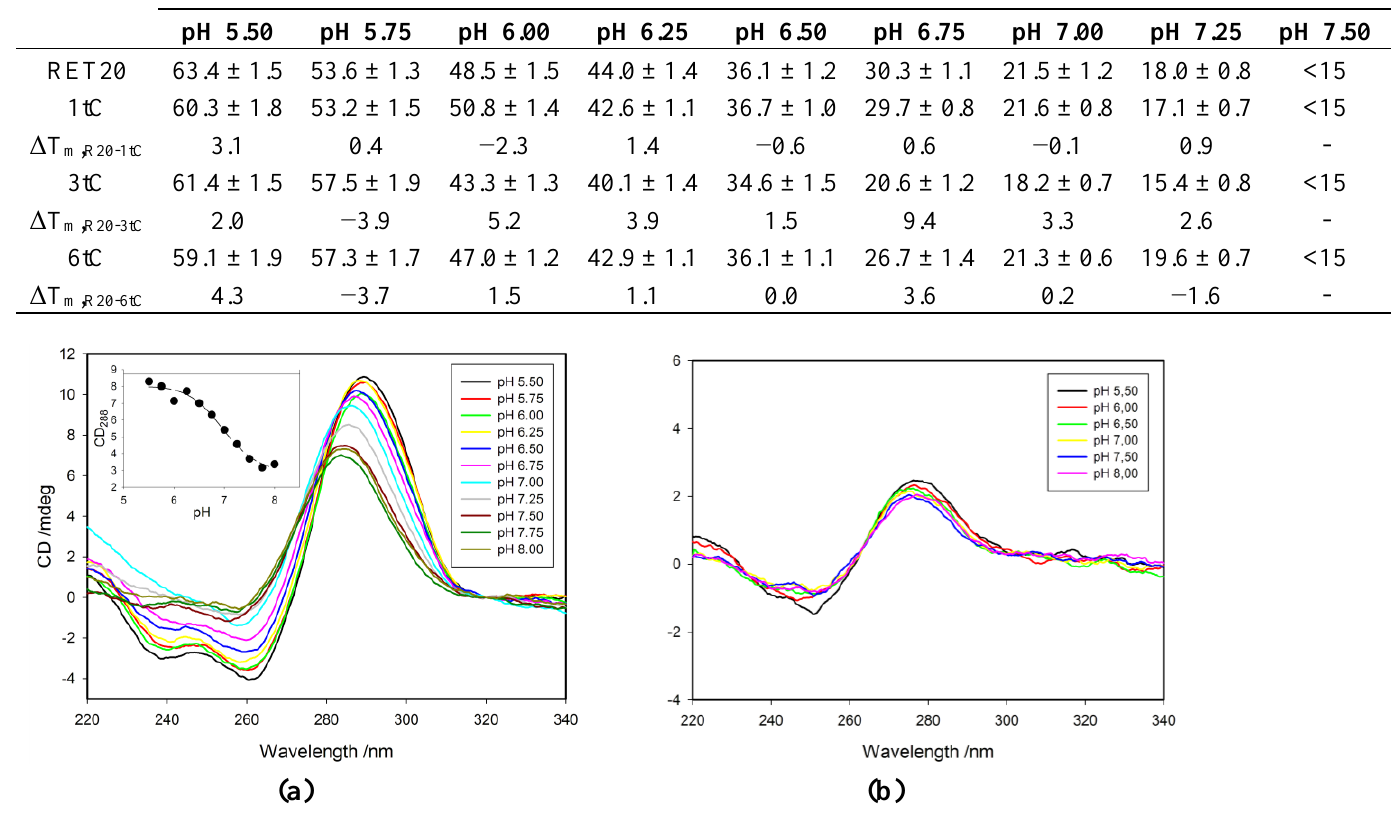
Table 2. Determined values of T m , Δ T m , R20-XtC and pH T for all probes at pH range 5.5–8.0 (R20 denotes RET20 sequence, X = 1, 3 or 6 position).